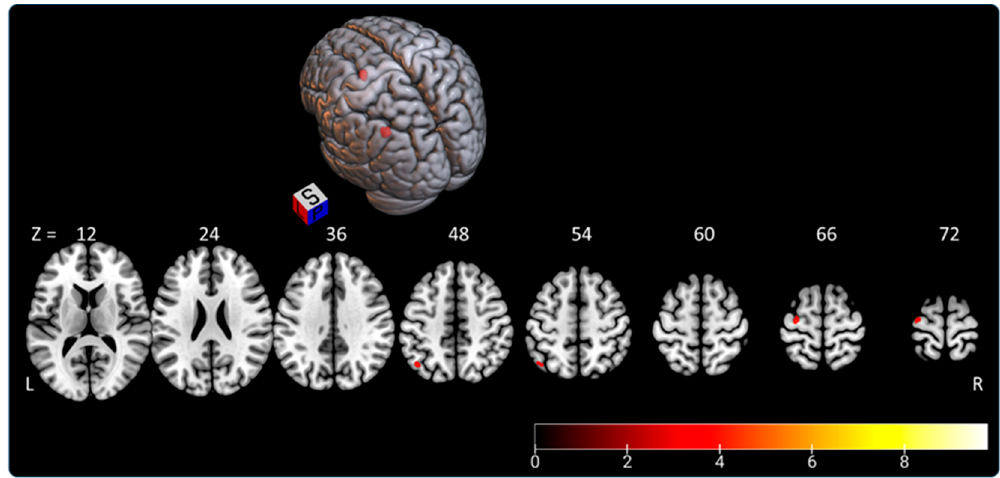
Figure 5. Rendered image of activated clusters highlighted by “SLB > SSA” contrast. The color bar indicates t ‐ values (BOLD); L—left, P—posterior, R—right, S—superior, Z coordinates in MNI atlas. Table 3. Activated areas highlighted by “SLB > SSA” contrast. The number of voxels is given for each cluster, together with the side (i.e., left or right hemisphere), the cluster composition (i.e., the percentage of voxels in each area assigned using AAL3 and brainnetome atlas), MNI coordinates and t value of the peak. Only activated areas covering more than 10% of the cluster are shown.